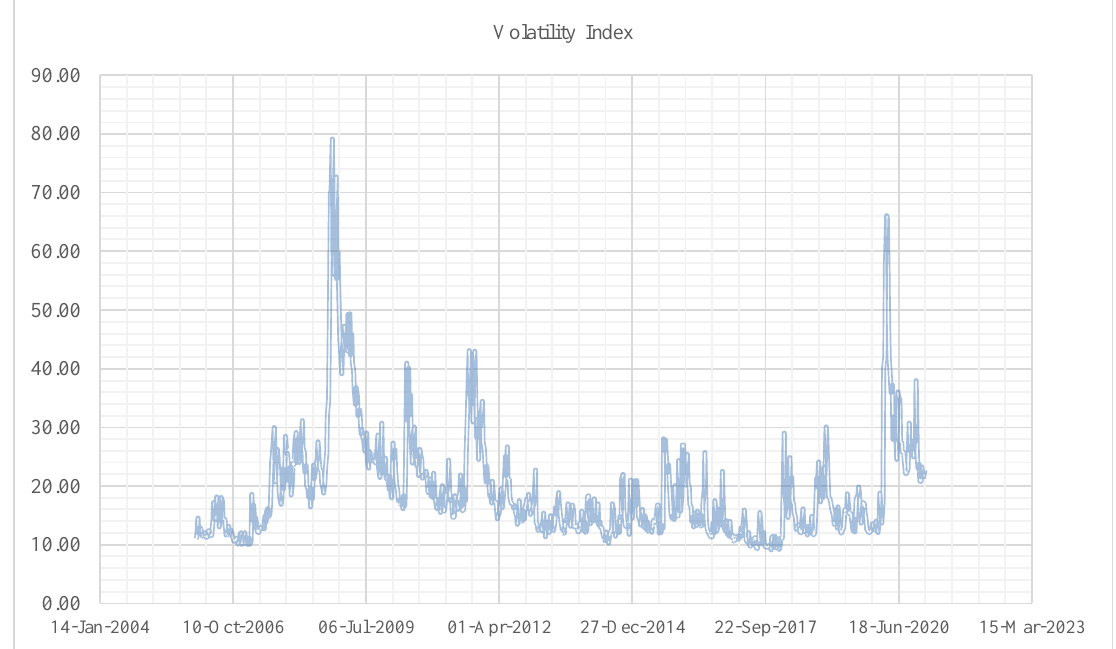
Figure 2: World Financial Markets Volatility Index; Source: Thompson Reuters,